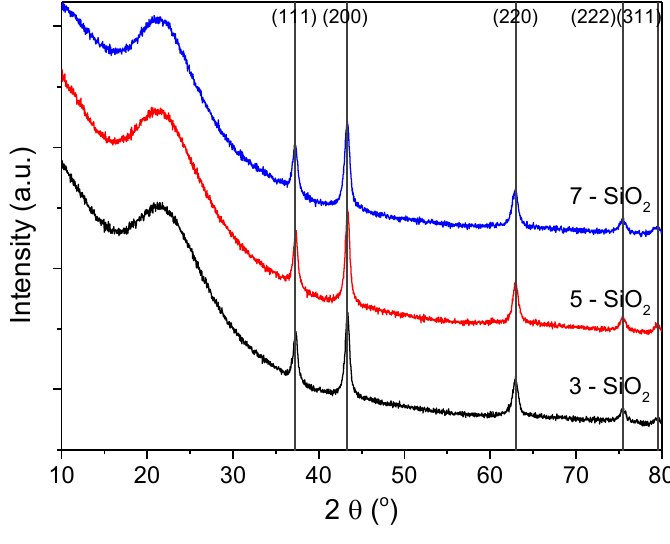
Figure 5. XRD patterns of 5% Ni on 3, 5 and 7-SiO 2